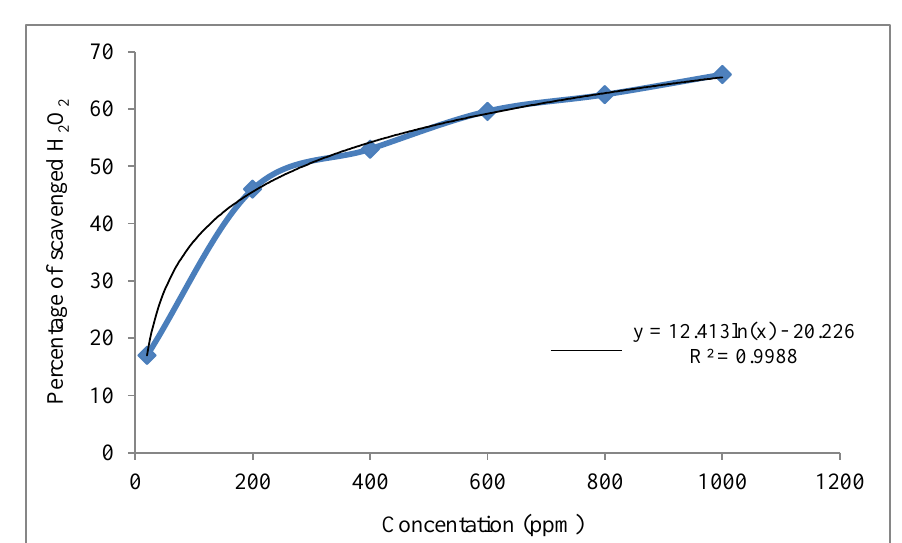
Figure 10. H 2 O 2 Scavenging activity of C 4